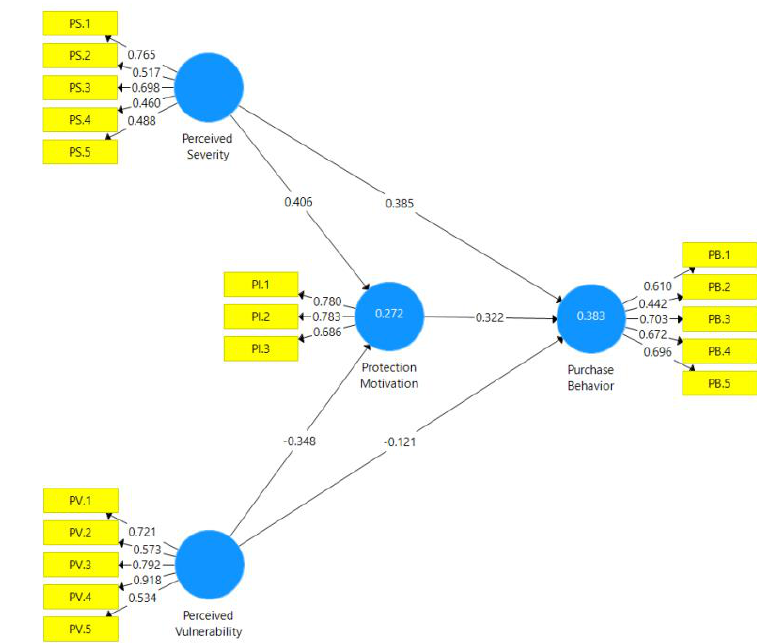
Figure 2: Structural Model of Research Model and Estimated Effect of Exogenous Variable